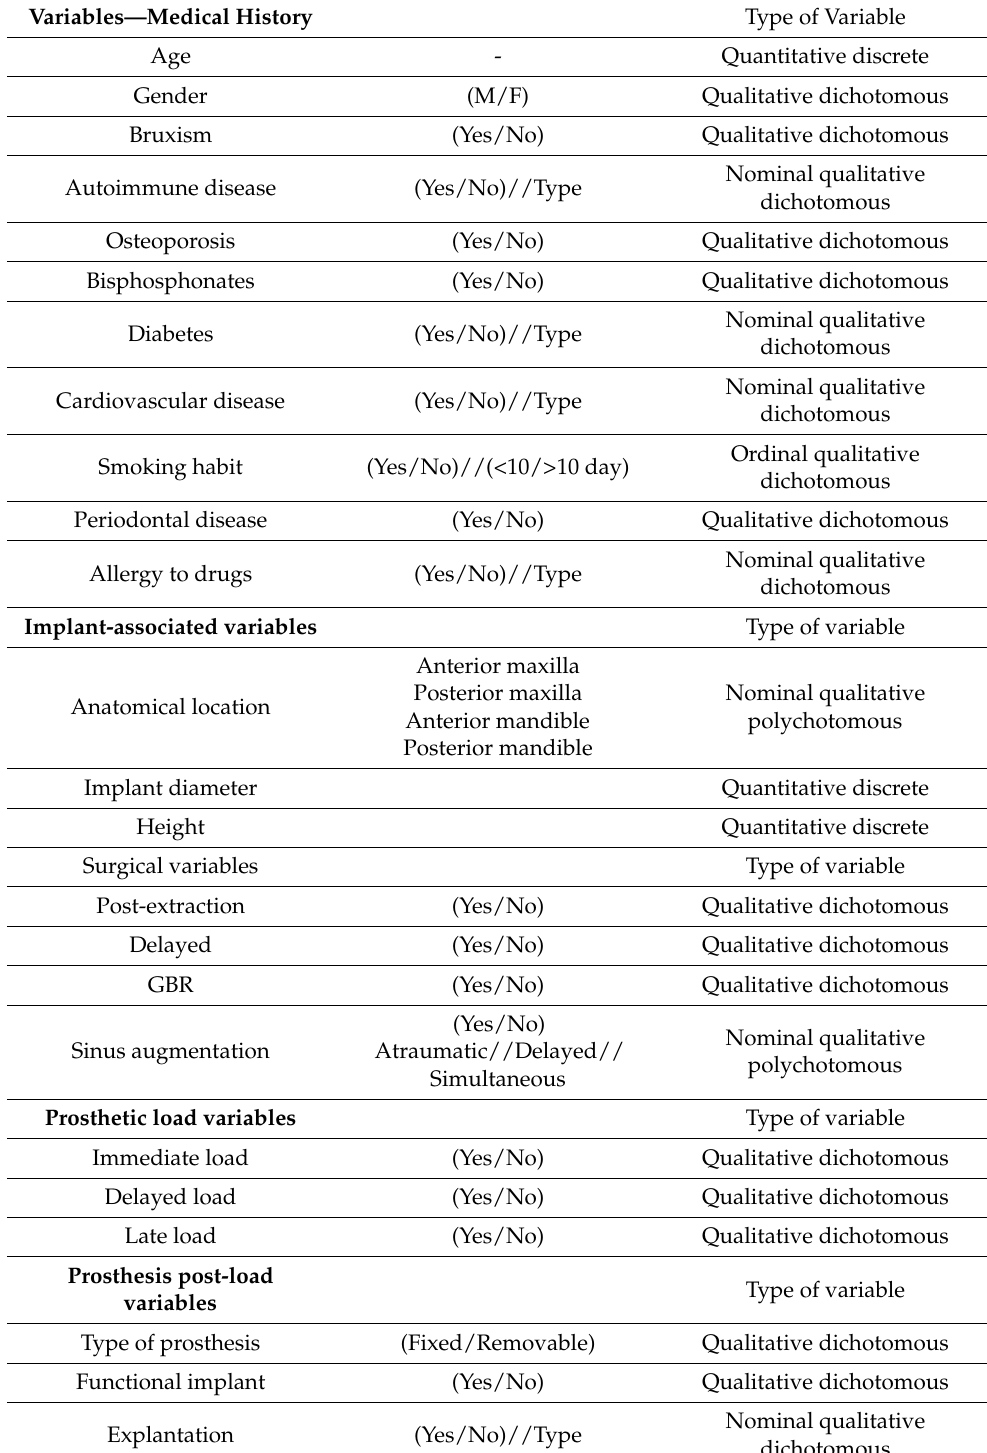
Table 1. Variables’ descriptions. M: Male; F: Female; Type: Refers to the type of autoimmune disease: Lichen, Psoriasis,